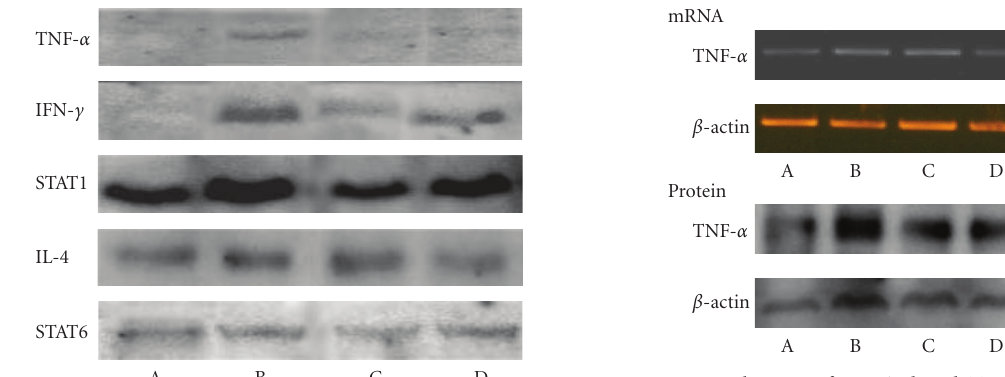
Figure 4: Changes of LPS-induced TNF- α mRNA and protein expression in RAW 264.7 cells. (A) 0 LPS, (B) 1 μ g LPS, (C) 3mg LPS, (D) 6mg LPS, (E) 9mg LPS, (F) 12mg LPS. B (TEL-TEST, Friendswood, TX, USA). Two